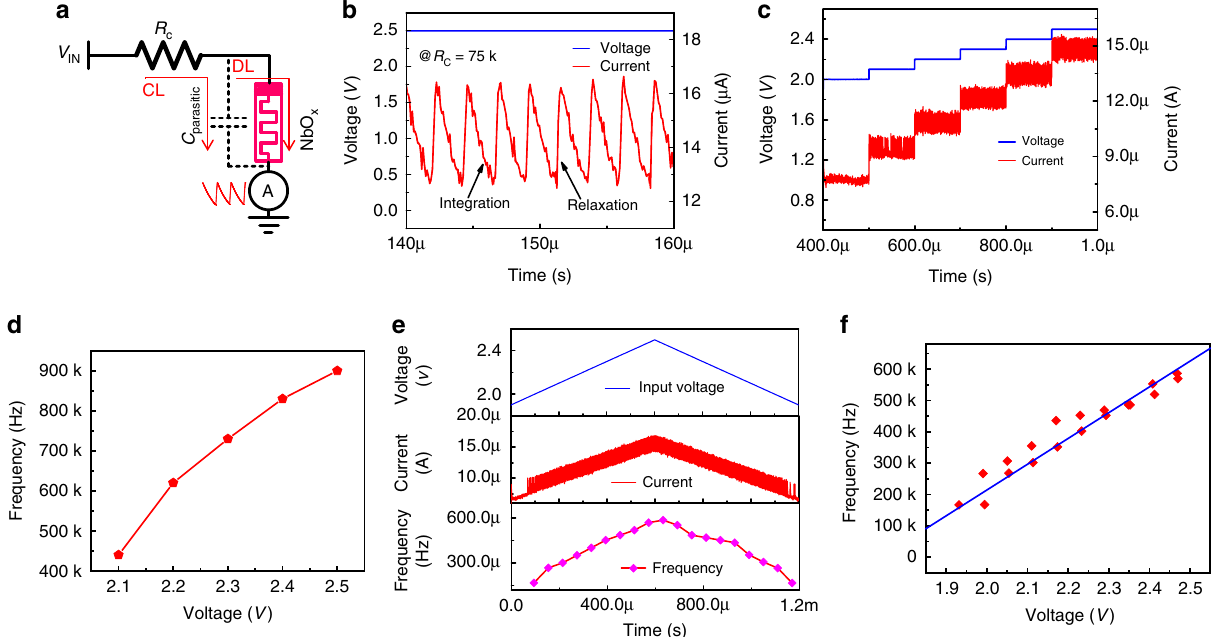
Fig. 3 Characteristics of the arti fi cial spiking afferent nerve (ASAN). a Schematic of the ASAN. A resistor R c (75 k Ω ) and a NbO x memristor with parallel parasitic capacitance are combined together ( R HRS >> R c >> R LRS ). In real applications, the voltage on NbO x top electrode serves as the output spiking signal. The parasitic capacitor ( C parasitic ) is tested to be about 20 pF. b The oscillation behavior of the ASAN. For the sake of simplicity, the current fl owing through the memristor is measured as the response. The charging time from V H to V TH is de fi ned as the integration time and the discharging time from V TH to V H as the relaxation time. c ASAN response under different input voltages. d Extracted mean value of spiking frequency vs. voltage in c . e Frequency response of the ASAN with triangular stimuli pulses. f The quasi-linear frequency – voltage curve extracted from e